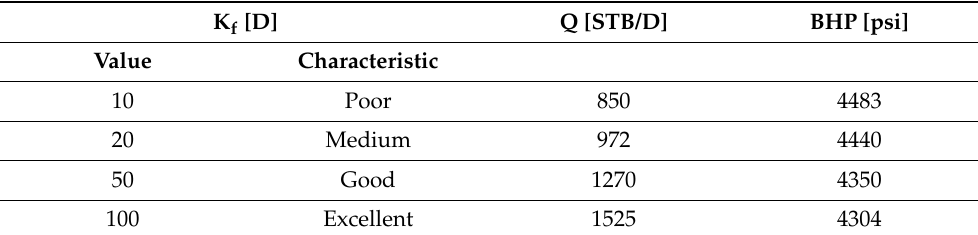
Figure 12. Final curves for the multistage fracturing scenario with optimized injection parameters (90 K-gal of fracturing fluid volume, 18 BPM injection rate, in three stages). Table 4. Sensitivity analysis of fracture permeability on production